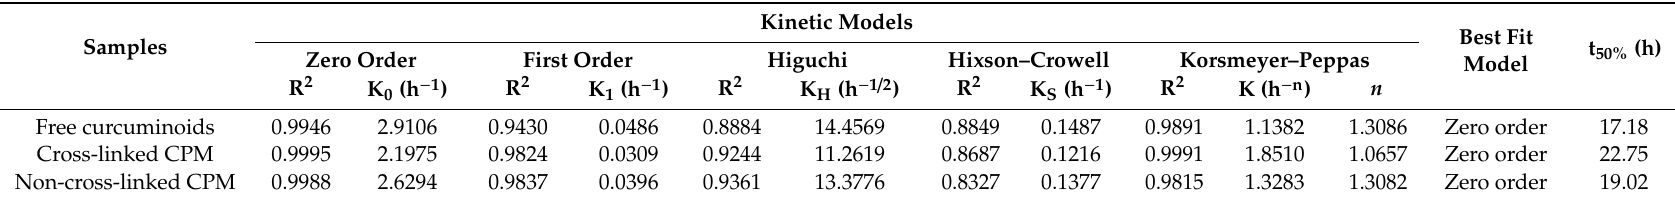
Table 2. Parameters of drug release kinetic models for free curcuminoids, cross-linked and non-cross-linked curcuminoids microcapsules (CPM).